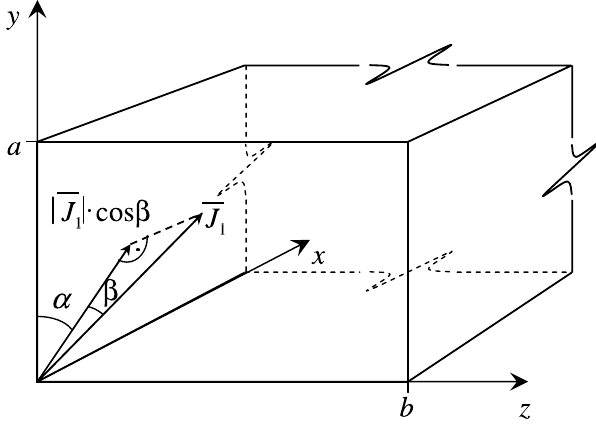
Fig. 7. The simplified geometric model applied for the UWB de- scription of the guided wave (tweek) propagation in the